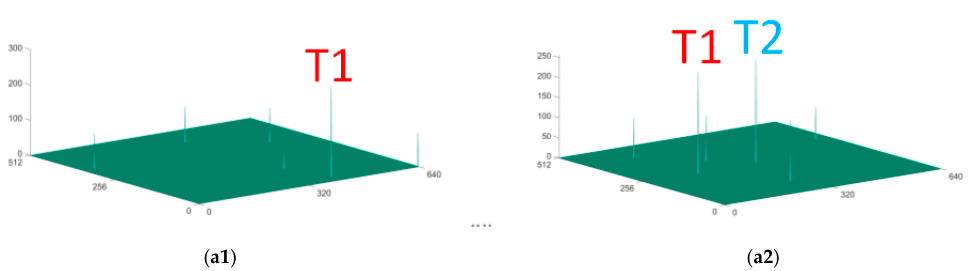
Figure 11. Peak significance re-measurement results of images A and B (Algorithm 3). ( a1 ) Re- measurement three dim result of image A. ( a2 ) Re-measurement three dim result of image B.